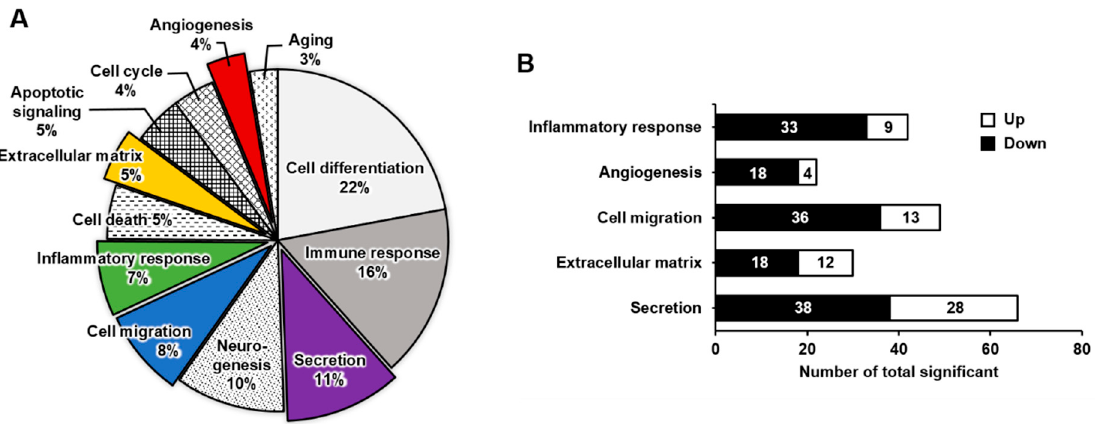
Figure 2. Upregulated or downregulated gene expression patterns associated with K562 cell differ- entiation into megakaryocytes, presented by gene category. ( A ) Pie chart illustrating the functional classification of differentially expressed genes between K562 cells and megakaryocytes. The ratio of genes with >2-fold change and a p -value < 0.05 is indicated. ( B ) The number of upregulated or downregulated genes in five selected clusters: inflammatory response, angiogenesis, cell migration, ex- tracellular matrix, and secretion.